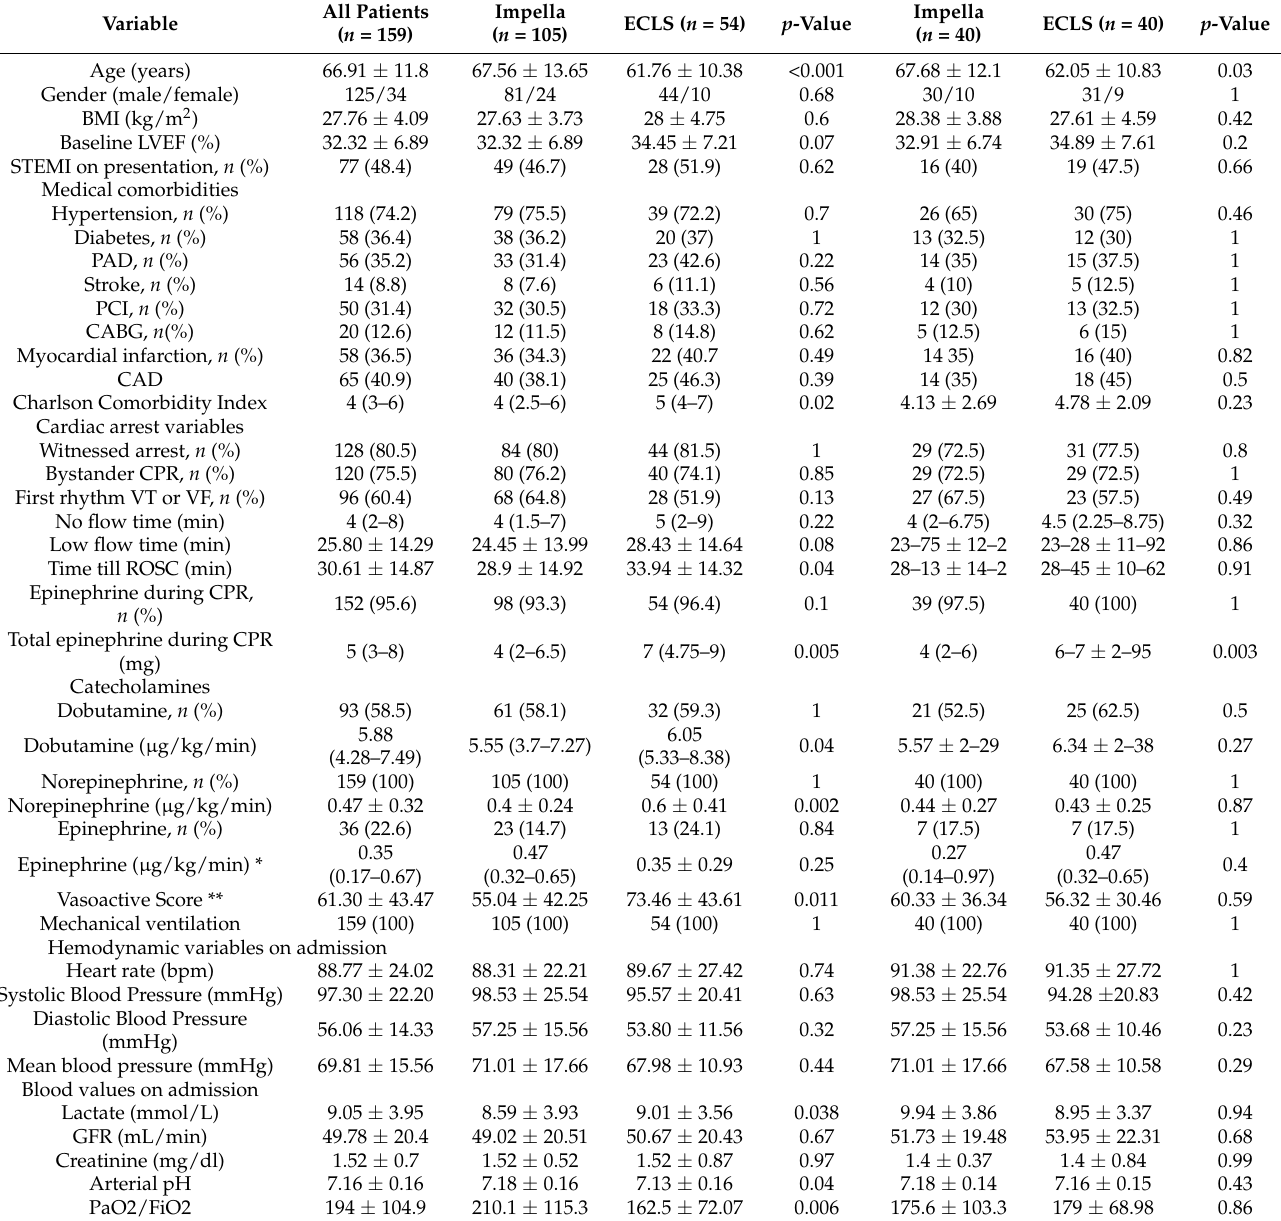
Table 1. Demographics and baseline characteristics from all patients and matched